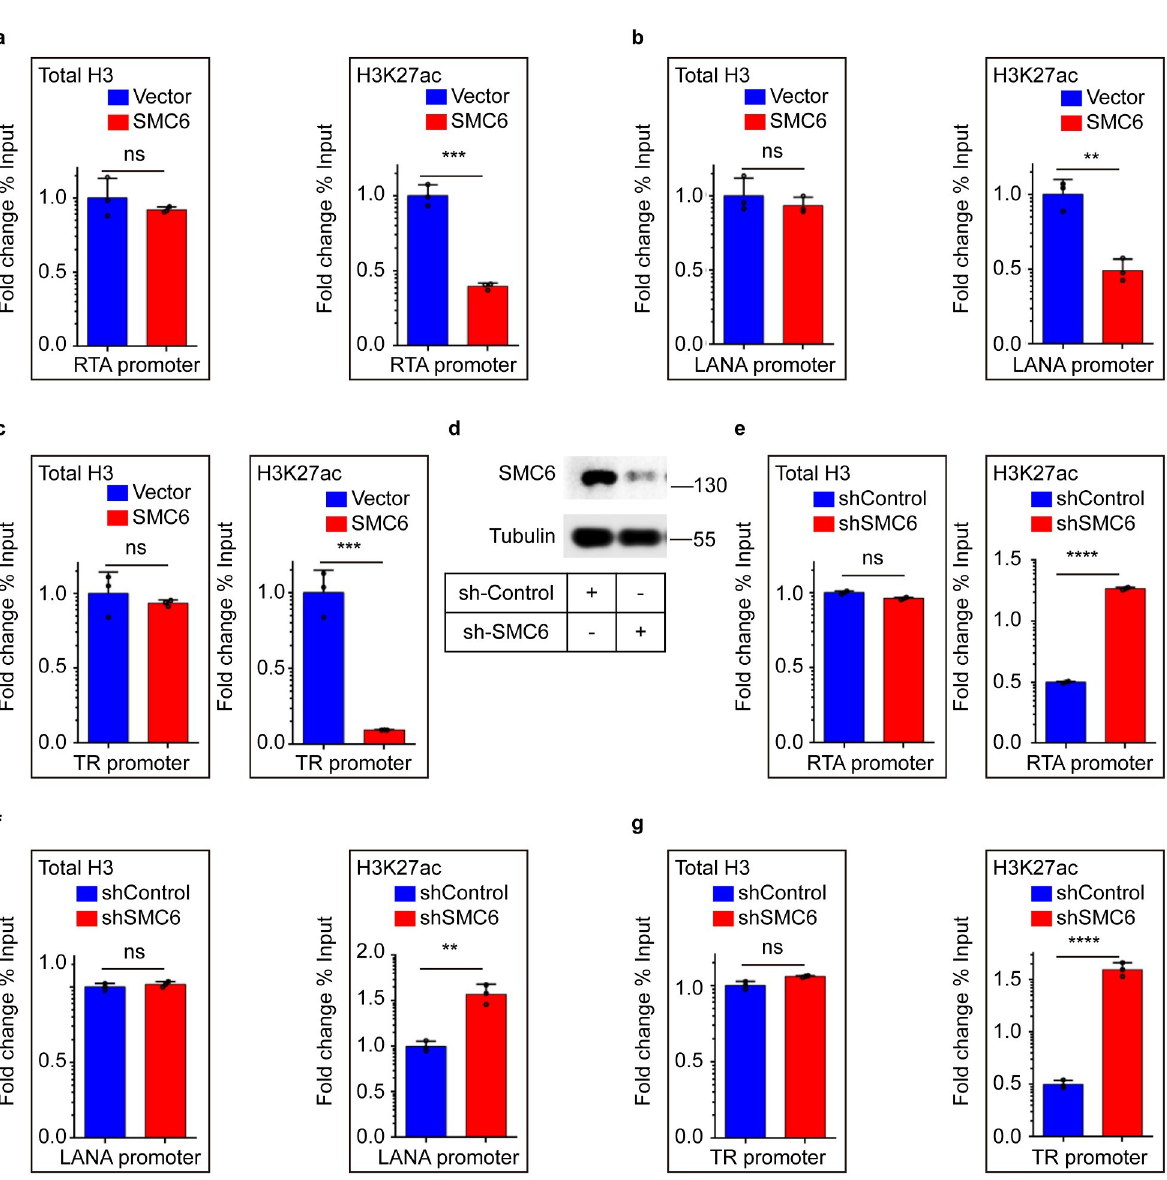
Fig 5. The SMC5/6 complex leads to a loss of H3K27ac on KSHV chromatin. (a-c) Ectopic expression of SMC6 decreases the levels of H3K27ac on KSHV genome. (a) H3K27ac on viral RTA was measured with ChIP-qPCR assay. ChIP was performed among latently infected control cells and SMC6-overexpressing cells by using antibodies against total H3 or H3K27ac. The recruitment of H3 and H3K27ac on KSHV RTA were tested via qPCR. Data was calculated as the fold change in percentage of input DNA compared with control ChIP experiment. (b) H3K27ac on viral LANA was measured with ChIP-qPCR assay. (c) H3K27ac on viral TR was measured with ChIP-qPCR assay. (d-g) Knockdown of SMC6 increases the levels of H3K27ac on KSHV genome. (d) iSLK.RGB cells were transduced with lentivirus expressing shRNA against SMC6. The knockdown efficiency was determined by western blots. (e-g) H3K27ac on viral RTA, LANA and TR were measured with ChIP-qPCR assay. ChIP was performed among latently infected control cells and SMC6 knockdown cells by using antibodies against H3 or H3K27ac. The recruitment of H3 and H3K27ac on KSHV genome were tested via qPCR. Representative results from three biological replicates are presented. Error bars indicate SD. Data were analyzed with Student’s t tests ( �� p < 0.01, ��� p <